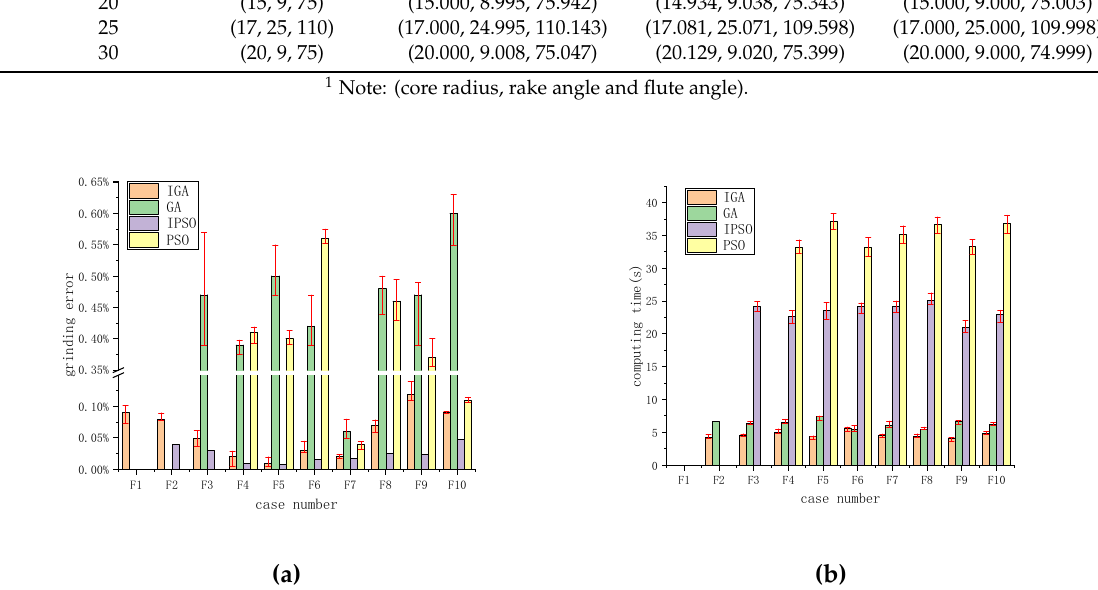
Figure 8. Simulated cutting tool flutes by CATIA.